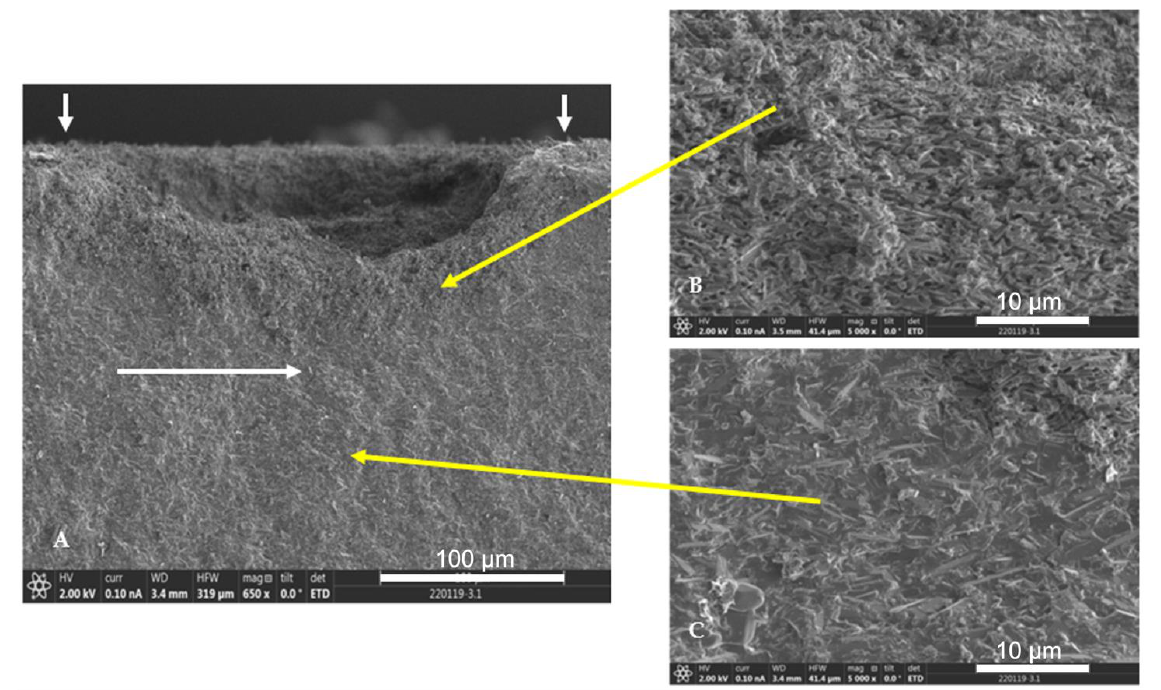
Figure 4. ( A ) SEM image of area around fracture origin for the pH cycling group. White arrows demarcate extent of corrosion layer; ( B ) higher magnification of alteration layer with dissolution of glassy phase of the material; ( C ) higher magnification of area below the alteration layer with crystals and glassy phase intact.